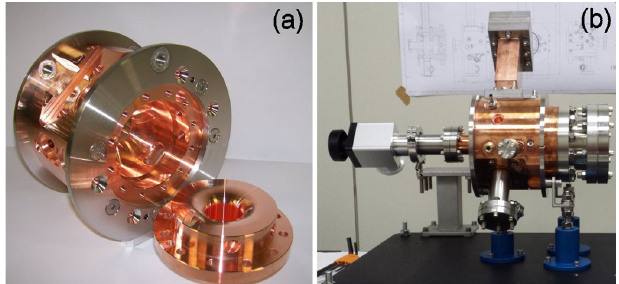
FIG. 8. Pictures of the gun before (a) and after the final assembly